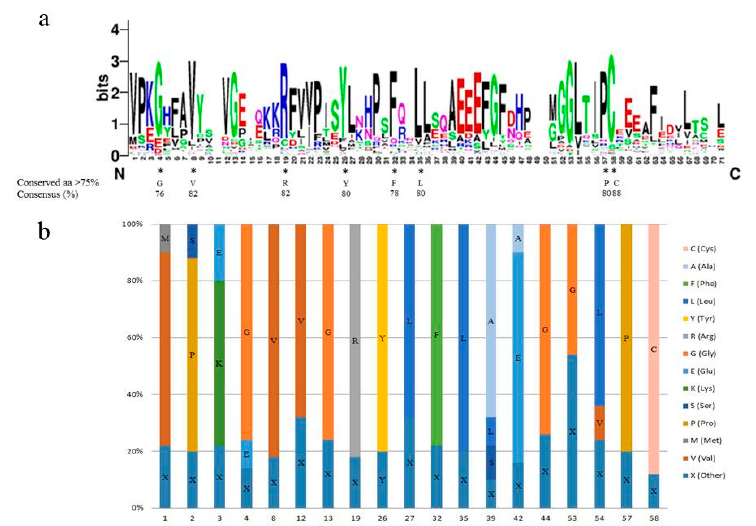
Figure 3. Characterization and distribution of VvSAUR domain. ( a ) Sequence logo of VvSAUR domain. Asterisks represent conserved amino acids that contain more than 75%. ( b ) Distribution of amino acids in the VvSAUR domain. Columns of different colors represent percentage of amino acids at this site.